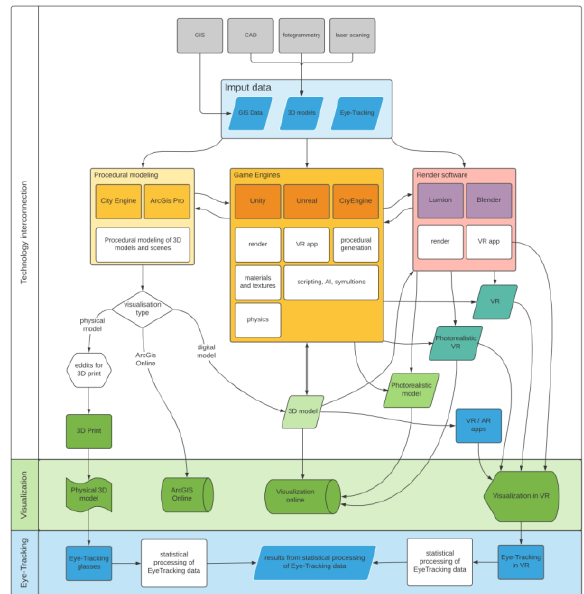
Figure 4 . Example of a diagram for technology